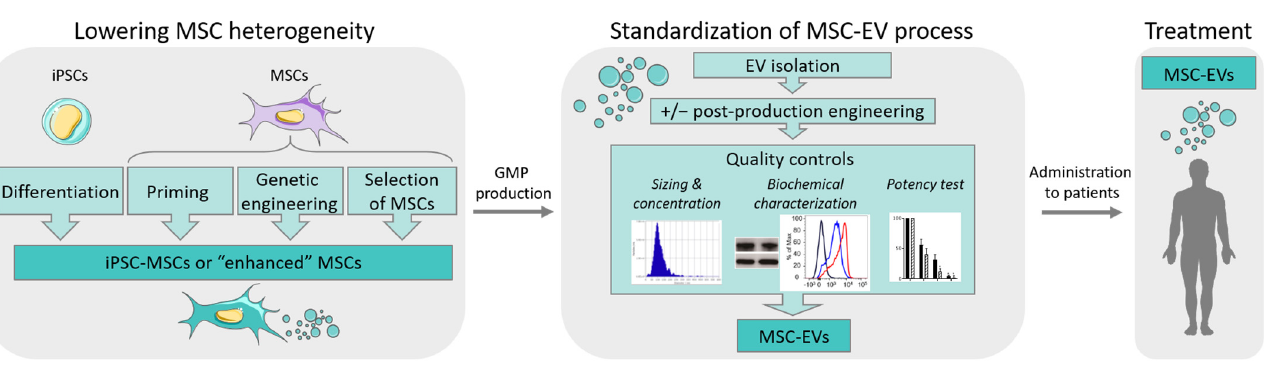
Figure 1. Strategies for optimizing MSC-EV production in regenerative medicine.